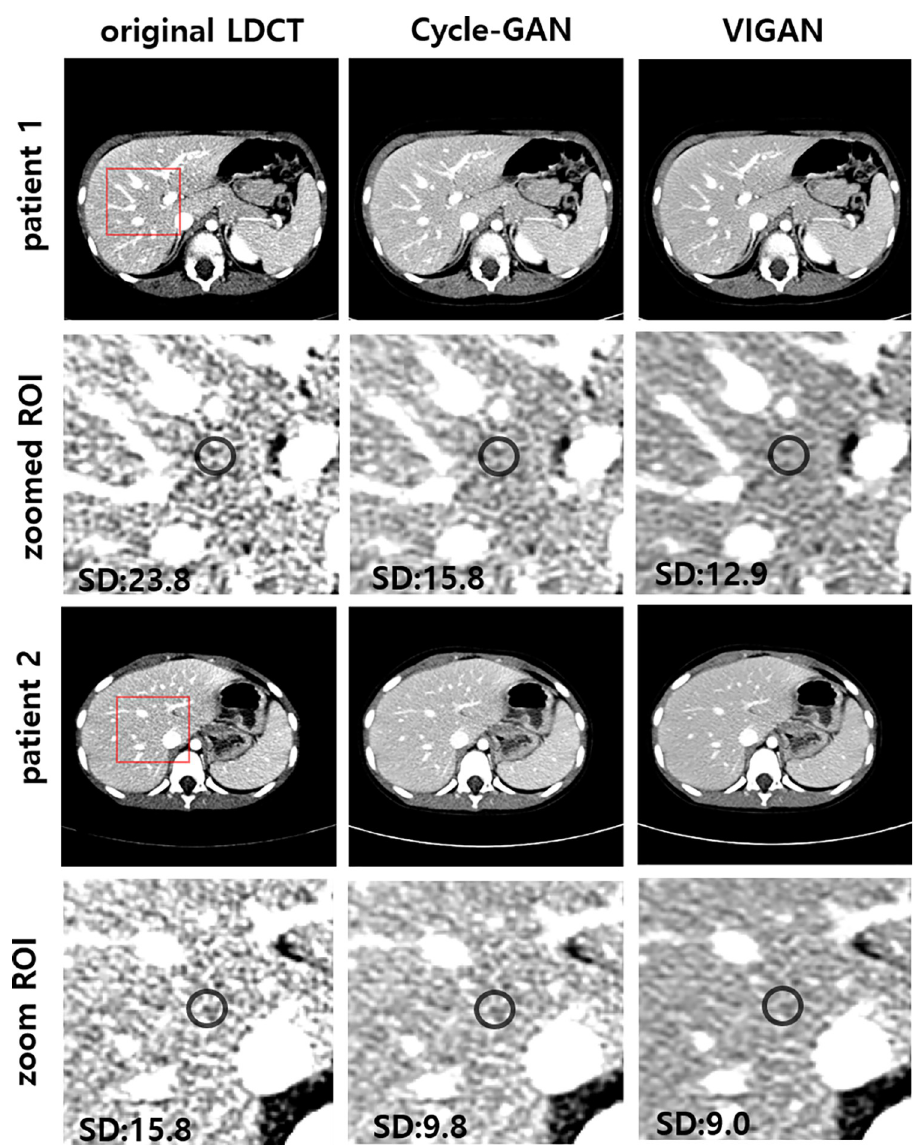
Fig 5. Images of original LDCT, Cycle-GAN, and VIGAN for validation set. Second and fourth rows show zoomed regions-of-interests marked with red rectangles in the images of the first and third rows. VIGAN achieves the lowest image noise (i.e., standard deviation(SD)) compared to Cycle-GAN and original LDCT. WL/WW = 115/250 for original LDCT. WL/WW = 85/250 for Cycle-GAN and VIGAN. image noise of VIs was estimated to be less than that of OIs ( p < 0.001). Both OIs and VIs were assigned more than 3 points, indicating "average noise in an acceptable image."